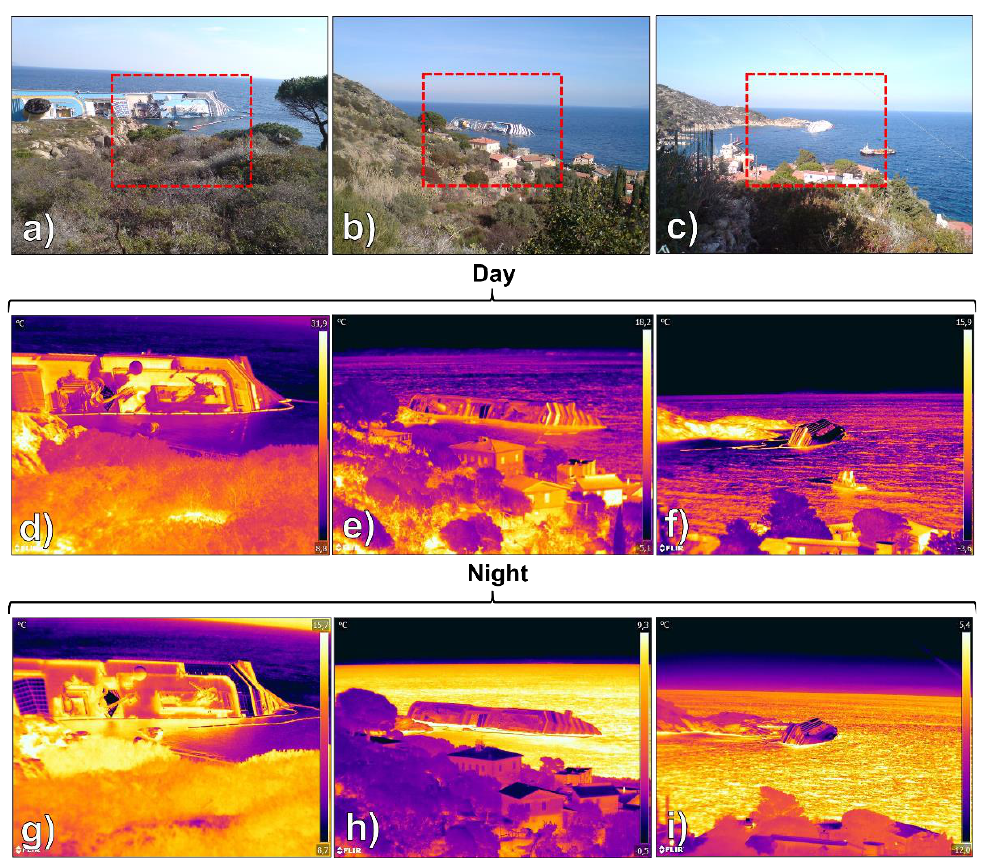
Figure 2. View of the Costa Concordia wreck from the acquiring points, showing the IR field of view (red dashed squares): ( a ) P1; ( b ) P2; ( c ) P3; examples of IRT thermograms during daytime from P1 ( d ), P2 ( e ); P3 ( f ), and during nighttime from P1 ( g ); P2 ( h ); P3 ( i ) (colorbar “iron”). Table 1. Technical features of the adopted thermal camera and IRT survey